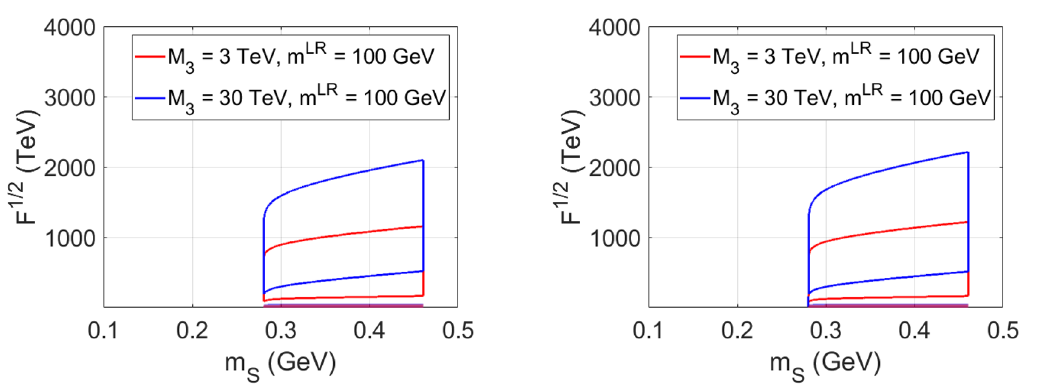
Figure 21 . FASER-I sensitivity to models with light sgoldstino decaying into mesons. Sgoldstinos are produced mostly in flavor-violating decays of η 0 -mesons. Only sgoldstino decays into charged mesons are considered for the plot. Both neutral and charged mesons are treated as sgoldstino signature for the right plot. A Q = 100 GeV. Shaded areas correspond to restrictions from table 1. √ √ In the regions where F < M 3 we set M 3 = F .